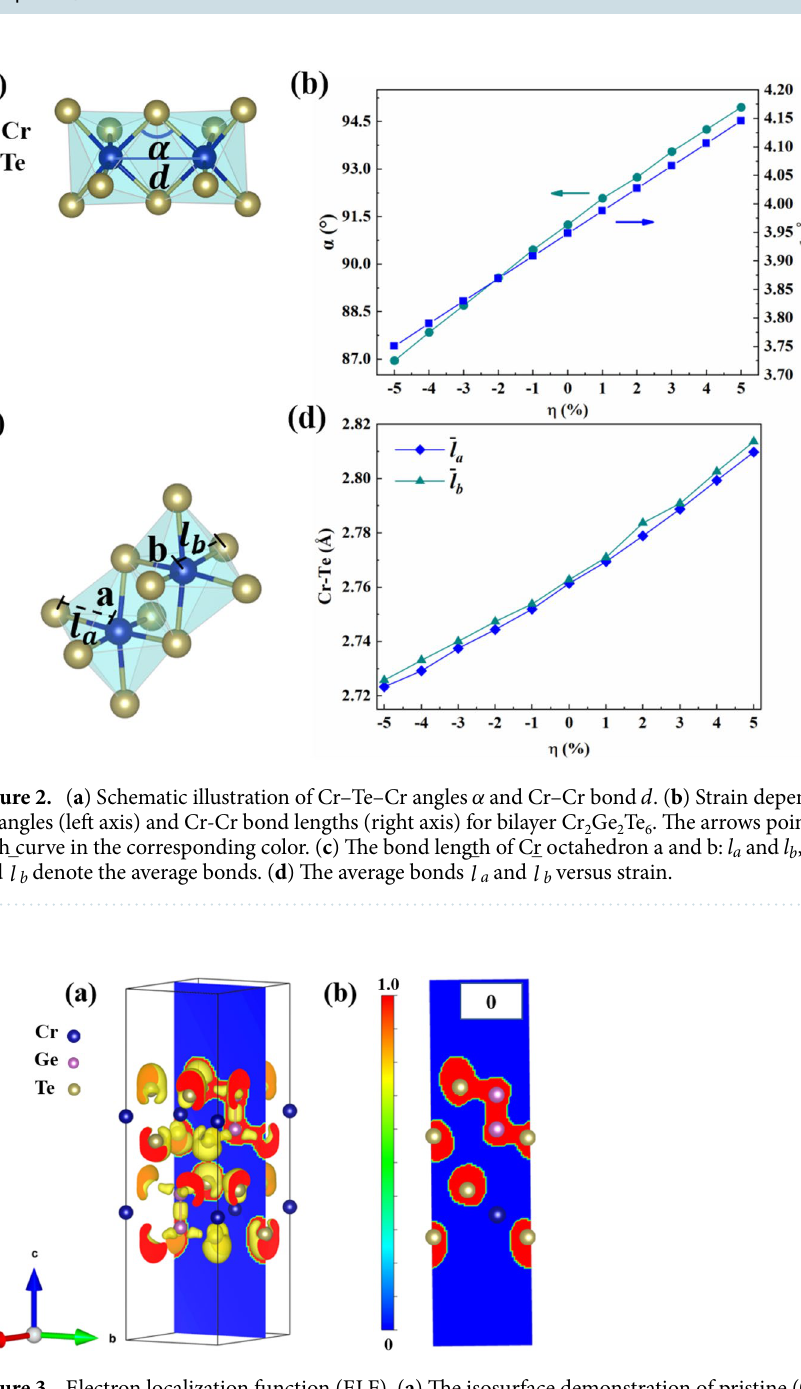
Figure 3. Electron localization function (ELF). ( a ) The isosurface demonstration of pristine (0) bilayer Cr 2 Ge 2 Te 6 . ( b ) The two-dimensional contour map in the direction of [001], the cut surface is shown in